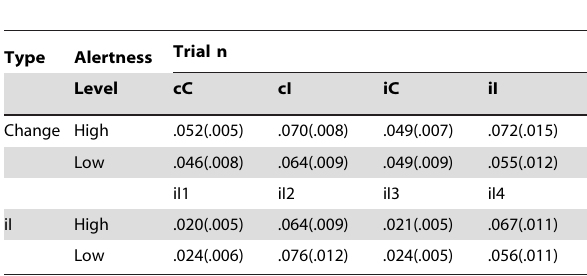
Table 6. Error rates (SE) for Transitions of Previous 6 Current Trial Type in experiment